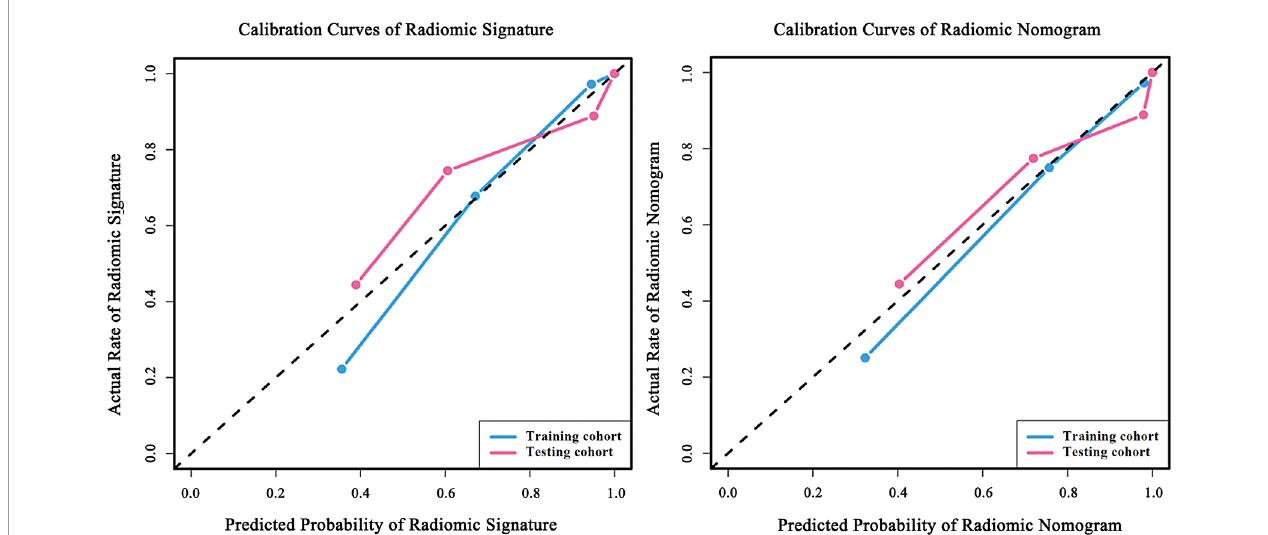
FIGURE 4 | Calibration curves of the radiomic model and the radiomic nomogram. Calibration curves of radiomic signature were built by the radiomic model based on DCE, DWI and T 2 WI. Calibration curves of radiomic nomogram were built by the nomogram. The diagonal line represents the perfect prediction of the ideal model. The blue and pink lines represent the performance of the training and testing cohort in the models, where the models closer to the diagonal line represent better predictions. The calibration curves have gone through the Hosmer-Lemeshow test and have achieved a favorite